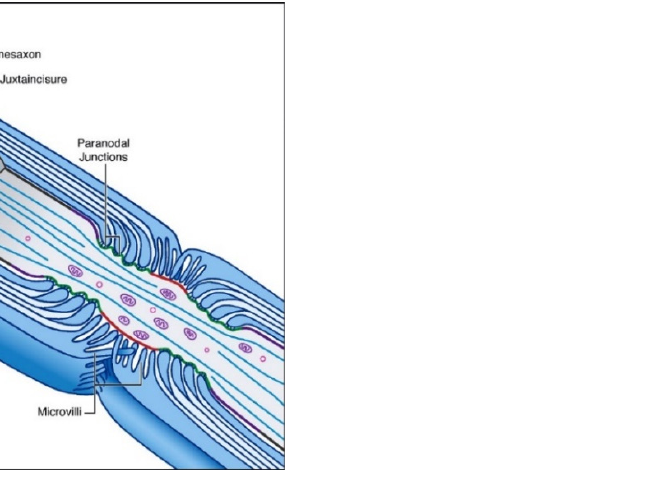
Figure 1. Morphology of myelinated PNS nerve, borrowed from Salzer with permission from Elsevier [65].